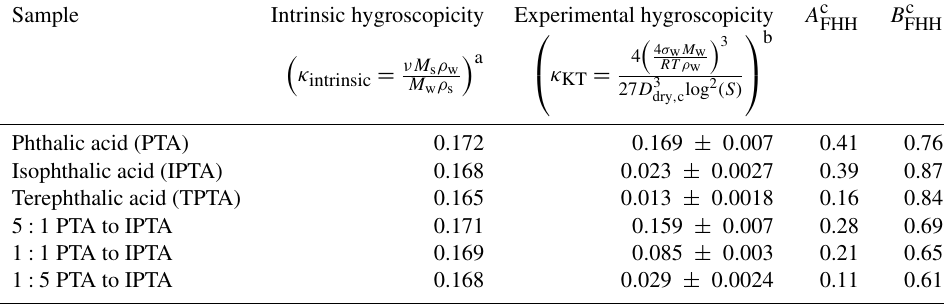
Table 2. Intrinsic and experimental hygroscopicity parameter and FHH empirical parameters used for FHH-AT and HAM analysis for pure and internally mixed AAA